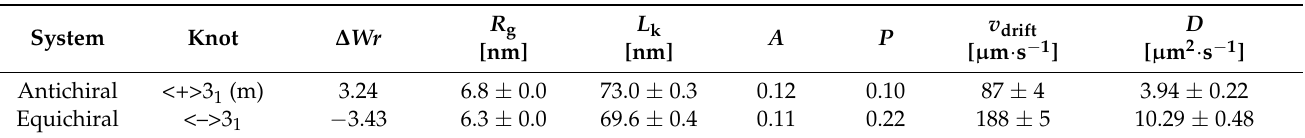
Table 2. Geometrical and dynamic measures of the knotoids confined in a helical tube with radius RH = 1.5 σ , R ch = 3 σ and pitch k = 1.5 σ